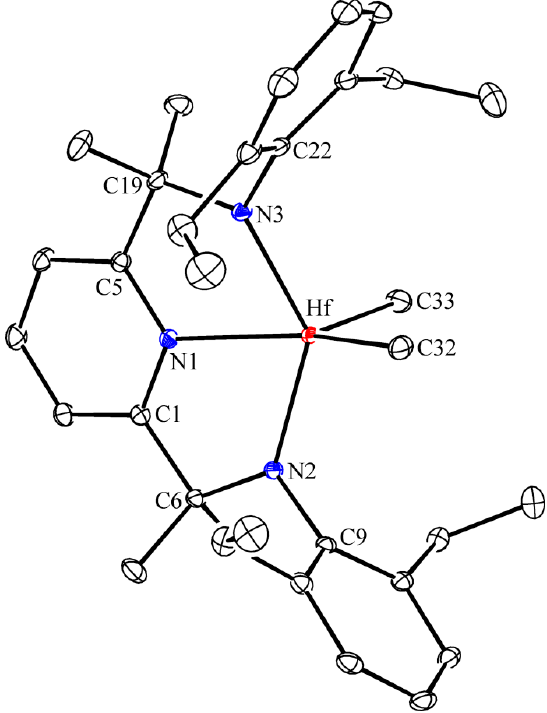
Figure 2. Thermal ellipsoid plot (30% probability level) of 4 . Hydrogen atoms are omitted for clarity. Selected bond distances (Å) and angles ( o ): Hf-N(1), 2.267(2); Hf-N(2), 2.084(2); Hf-N(3), 2.088(2); Selected bond distances (Å) and angles ( ◦ ): Hf-N(1), 2.267(2); Hf-N(2), 2.084(2); Hf-N(3),